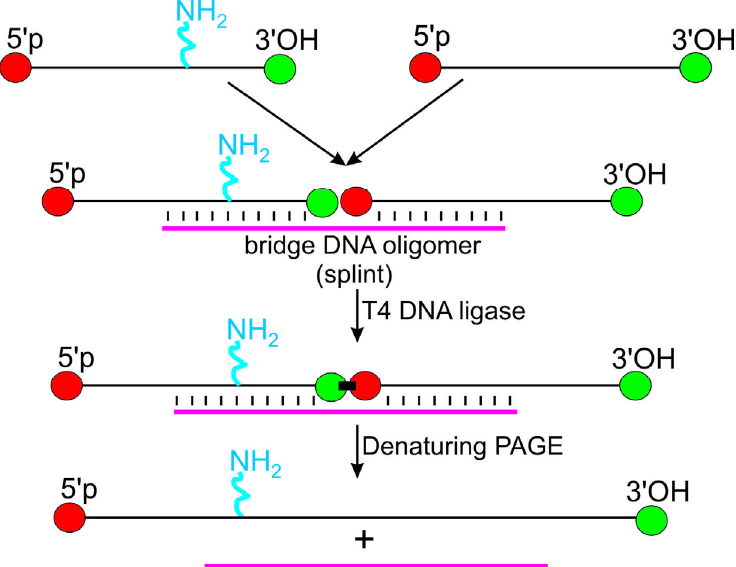
Scheme 1. Scheme of assembly of an amino linker-containing RNA from its fragments based on splint-aided ligation. PAGE, polyacrylamide gel electrophoresis. Interactions between complementary sequences of RNA fragments and the DNA splint are